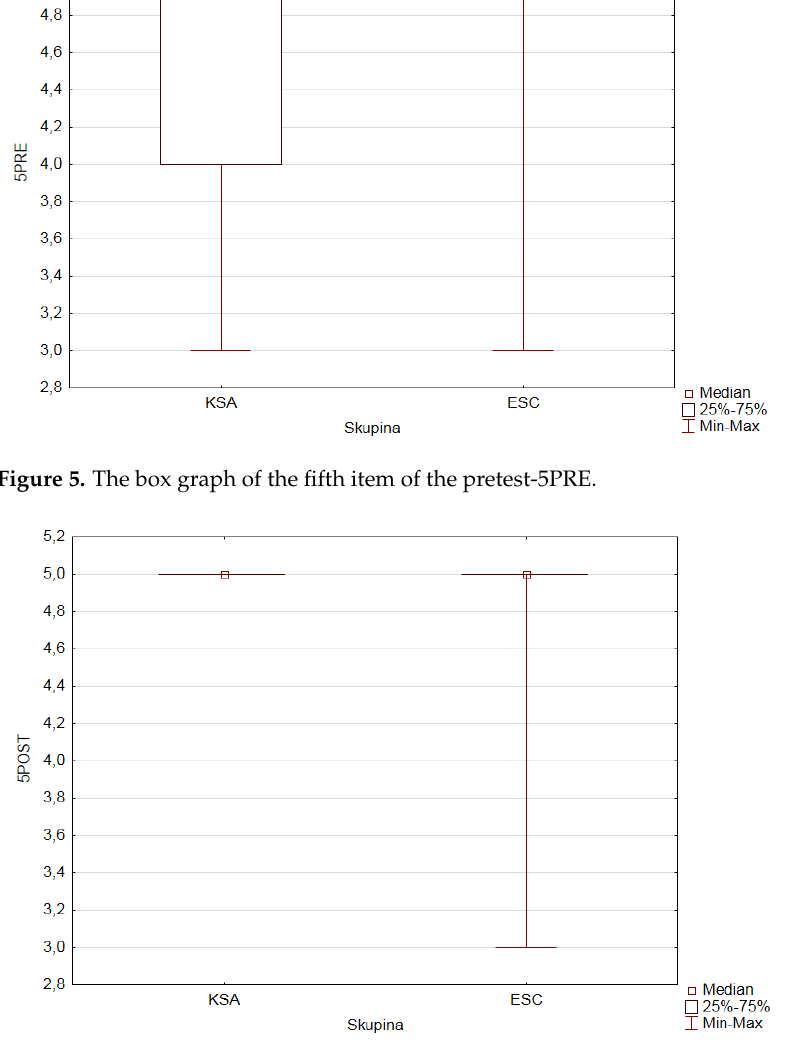
Figure 7. The box graph of the second item of the pretest - 2PRE.